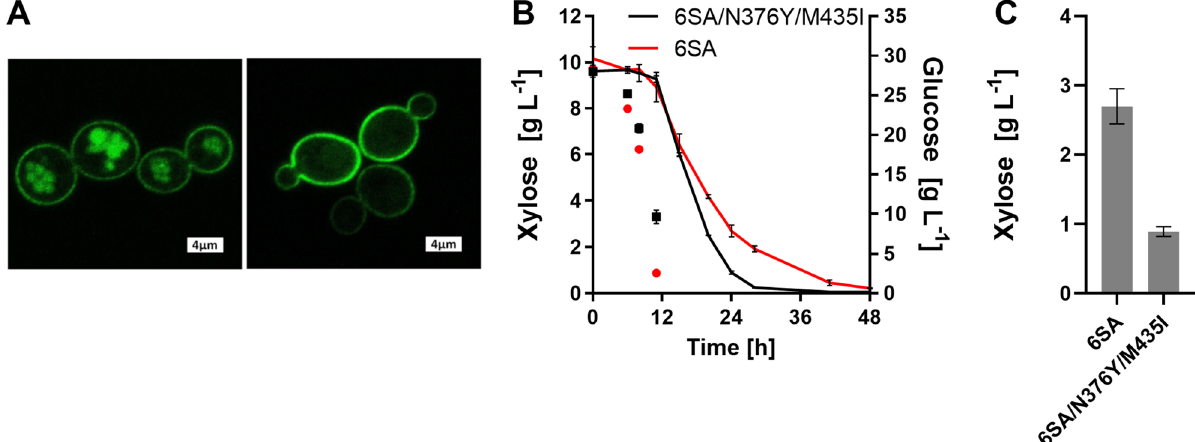
Figure 4. Stabilization of Gal2 variants by the 6SA N-terminal tail. The sextuple mutation within the N-terminal tail (6SA) conferring resistance to glucose-induced internalization was combined with the indicated Gal2 variants. ( A ) N376Y/M435I (left) and 6SA/N376Y/M435I (right) Gal2 variants were expressed as GFP fusions from single copy plasmids in CEN.PK2-1C and the localization of the transporters was analyzed by fluorescence microscopy. ( B ) The consumption of xylose (starting concentration 10 g L −1 , solid lines; plotted on the left Y axis) and glucose (starting concentration 30 g L −1 ; symbols only, plotted on the right Y axis) was measured via HPLC analysis. The mean values and standard deviation of three independent cultures are shown. The error bars may be smaller than the symbols. ( C ) Residual xylose concentration measured after 24 h of fermentation is shown. The values differ significantly (unpaired two-tailed t test, P < 0.01). The fermentation experiments in ( B ) and ( C ) were performed with the strain SRY027, in which the Gal2 constructs were expressed from multicopy plasmids.